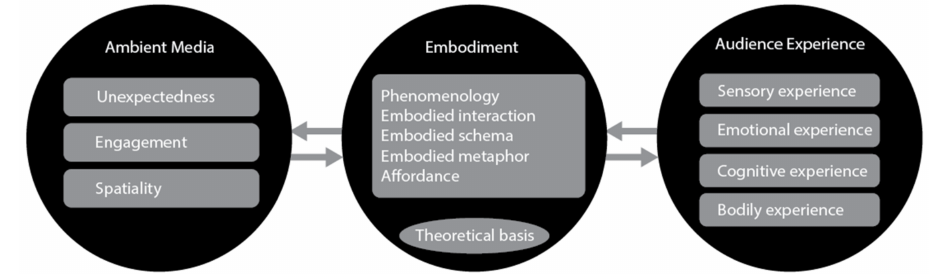
Figure 1. The theoretical framework of ambient media